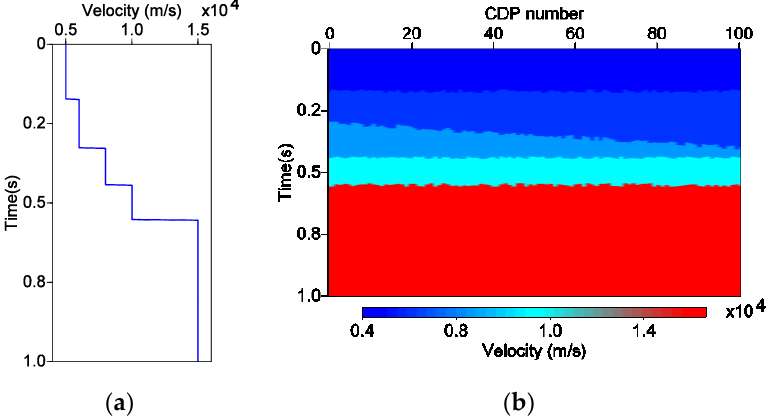
Figure 11. ( a ) Interval velocity curve at CDP 30; ( b ) extrapolation velocity result under the paths constraint.